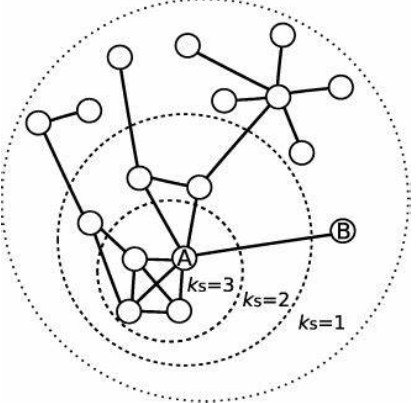
Figure 1. K_shell algorithm for finding the core nodes.